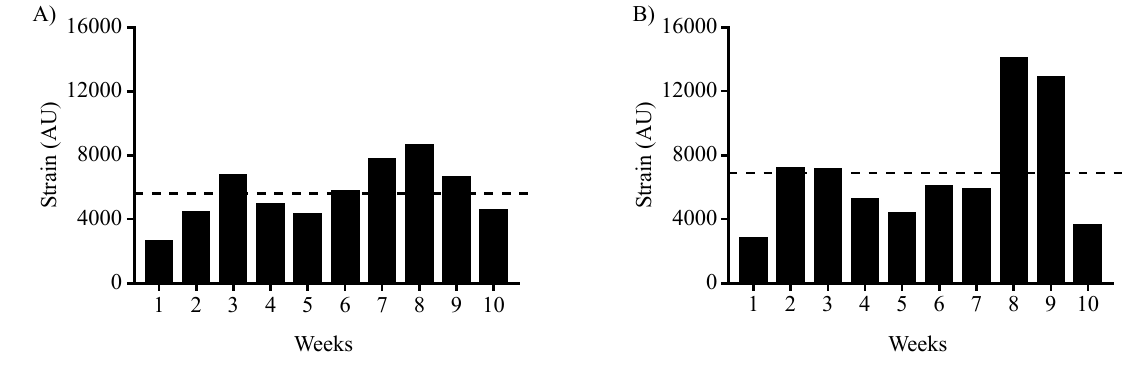
Figure 3. Each training week strain average represented by the dotted line for the defender (A) and blocker (B).